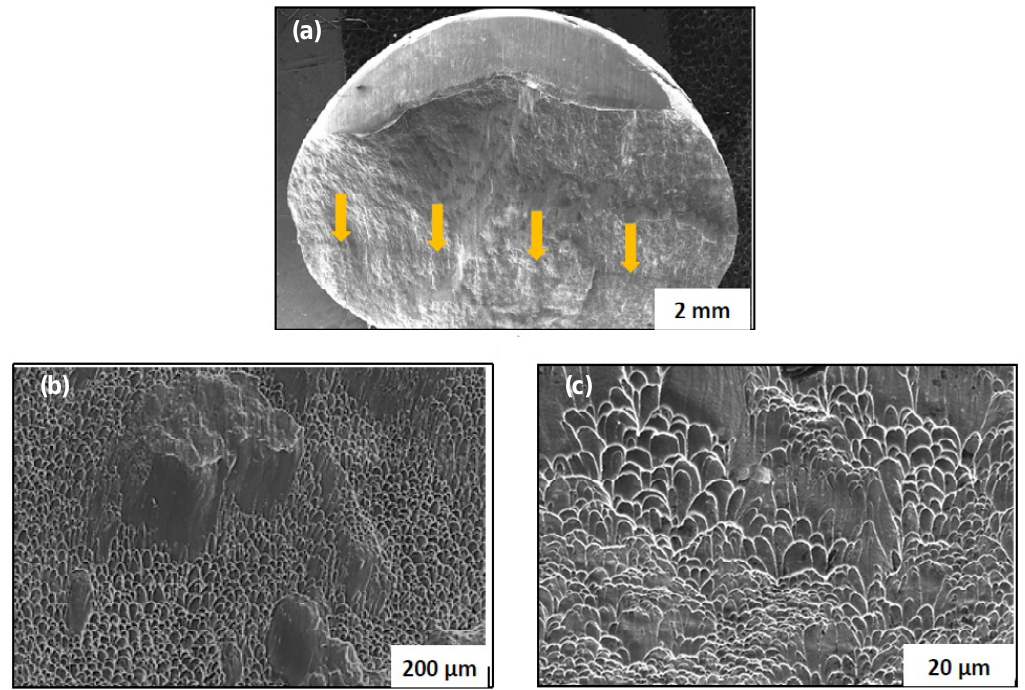
Fig. 9. General view of fractured specimen (a) and details of fractured zone for (b, c) for nanostructured LFW titanium after compression test.